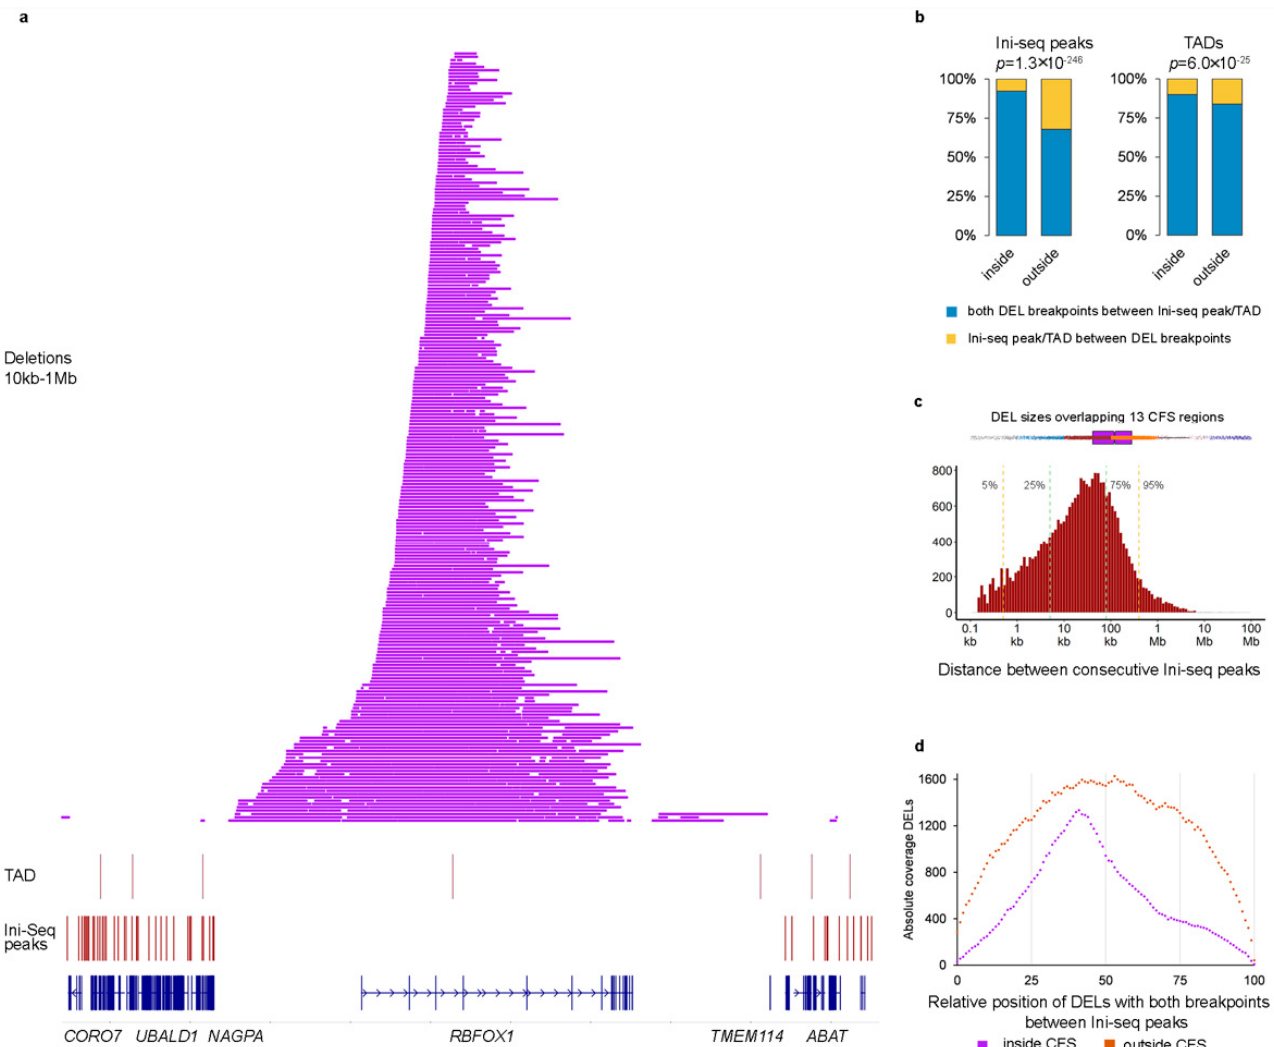
Figure 2. Origins of replication determine size of deletions in CFS. ( a ) Chromosome 16 region containing RBFOX1 . Indicated are (bottom to top) the locations of genes, Ini-seq peaks, TADs, and DELs between 10 kb–1 Mb. ( b ) Bar graph showing enrichment of Ini-seq peaks/TADs inside CFS regions. p -values via Mann–Whitney U -test. ( c ) Top horizontal boxplot shows the size of all DELs within or overlapping the 13 CFS regions. DELs are colored by size according to the groups in ( c ). Bottom histogram shows the distribution of distance between 2 consecutive Ini-seq peaks. Vertical lines show the indicated percentiles. ( d ) Relative position of DELs between consecutive Ini-seq